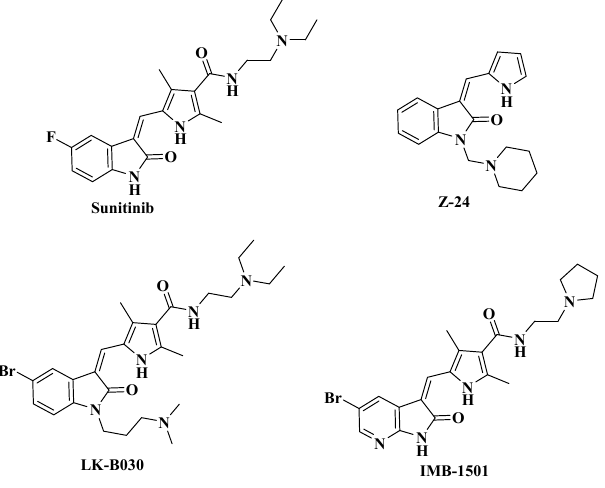
Figure 1. Structures of Sunitinib, Z-24, LK-B030 and IMB-1501.